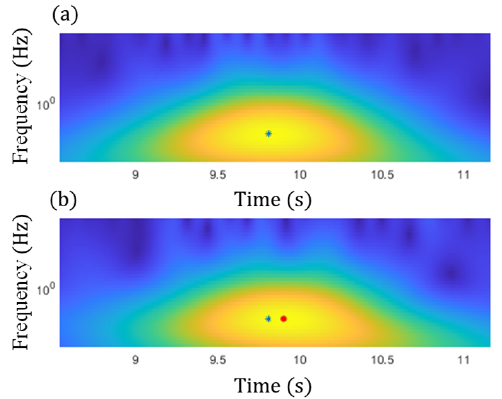
Figure 20. Peak identification within the identified WOIs under the single traffic event for ( a ) strain, F ( t ) , measurement, and ( b ) ∆ C ( t ) from SEC.